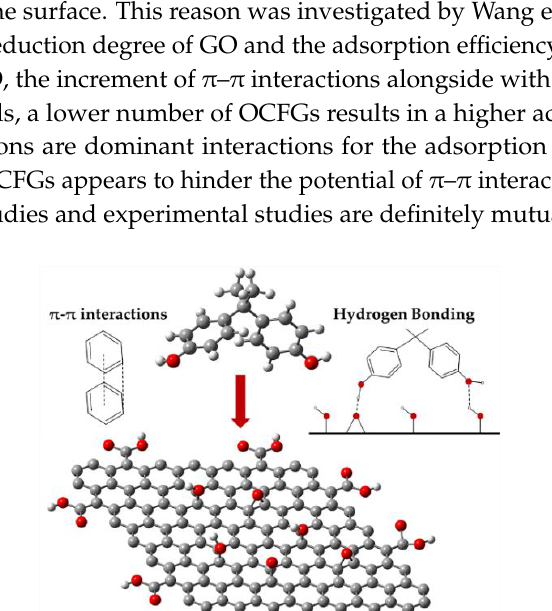
Figure 10. Schematic representation of π–π interactions and hydrogen bonding between BPA and GO.